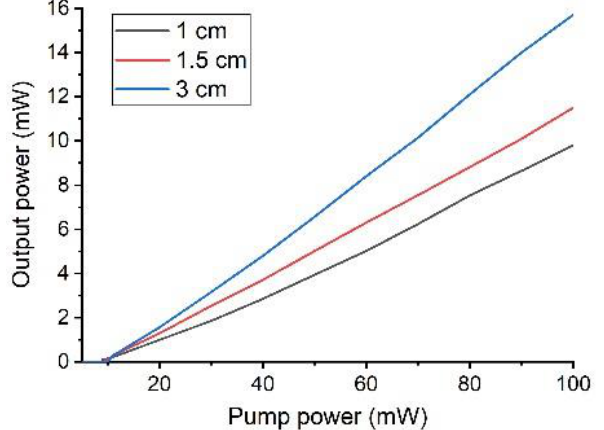
Figure 3. Laser output power versus pump power for three different lengths of the active fiber in a scheme with a long cavity.